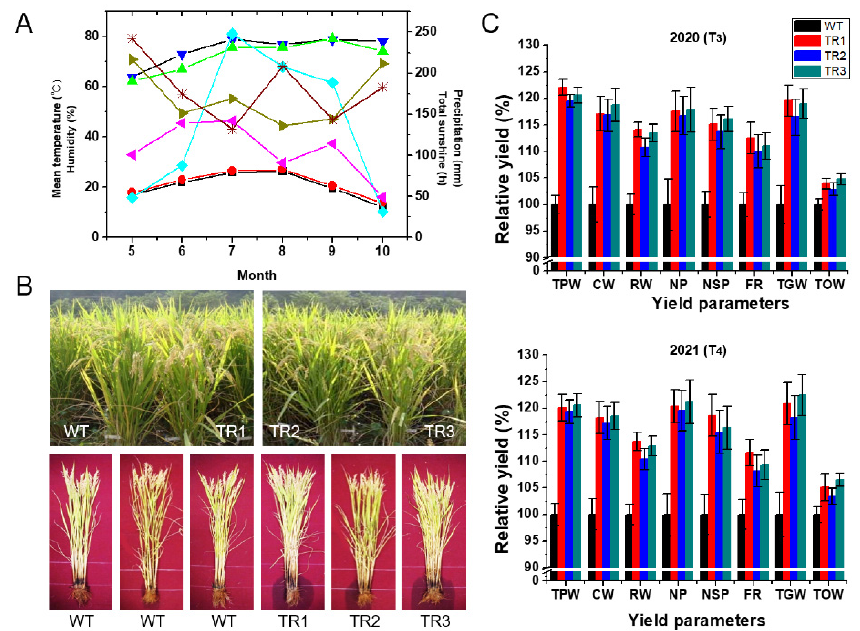
Figure 3. Agronomic traits of transgenic and wild-type rice plants grown under paddy-field conditions. ( A ) Weather conditions during the cultivation period (May to October) of 2020 and 2021, including mean temperature (2020, black square; 2021, red circle), precipitation (2020, cyan diamond; 2021, magenta left-triangle), total sunshine (2020, dark yellow right-triangle; 2021, wine star), and humidity (2020, green up-triangle; 2021, blue down-triangle). ( B ) Phenotypes of middle- (upper panel) and late-reproductive stage plants (lower panel) in 2021. ( C ) Relative agronomic traits of TR and WT plants in 2020 (T 3 ) and 2021 (T 4 ). TR, transgenic rice; WT, wild-type rice; TPW, total plant weight; CW, culm weight; RW, root weight; NP, number of panicles per hill; NSP, number of spikelets per panicle; FR, filling rate; TGW, total grain weight; TOW, 1000-grain